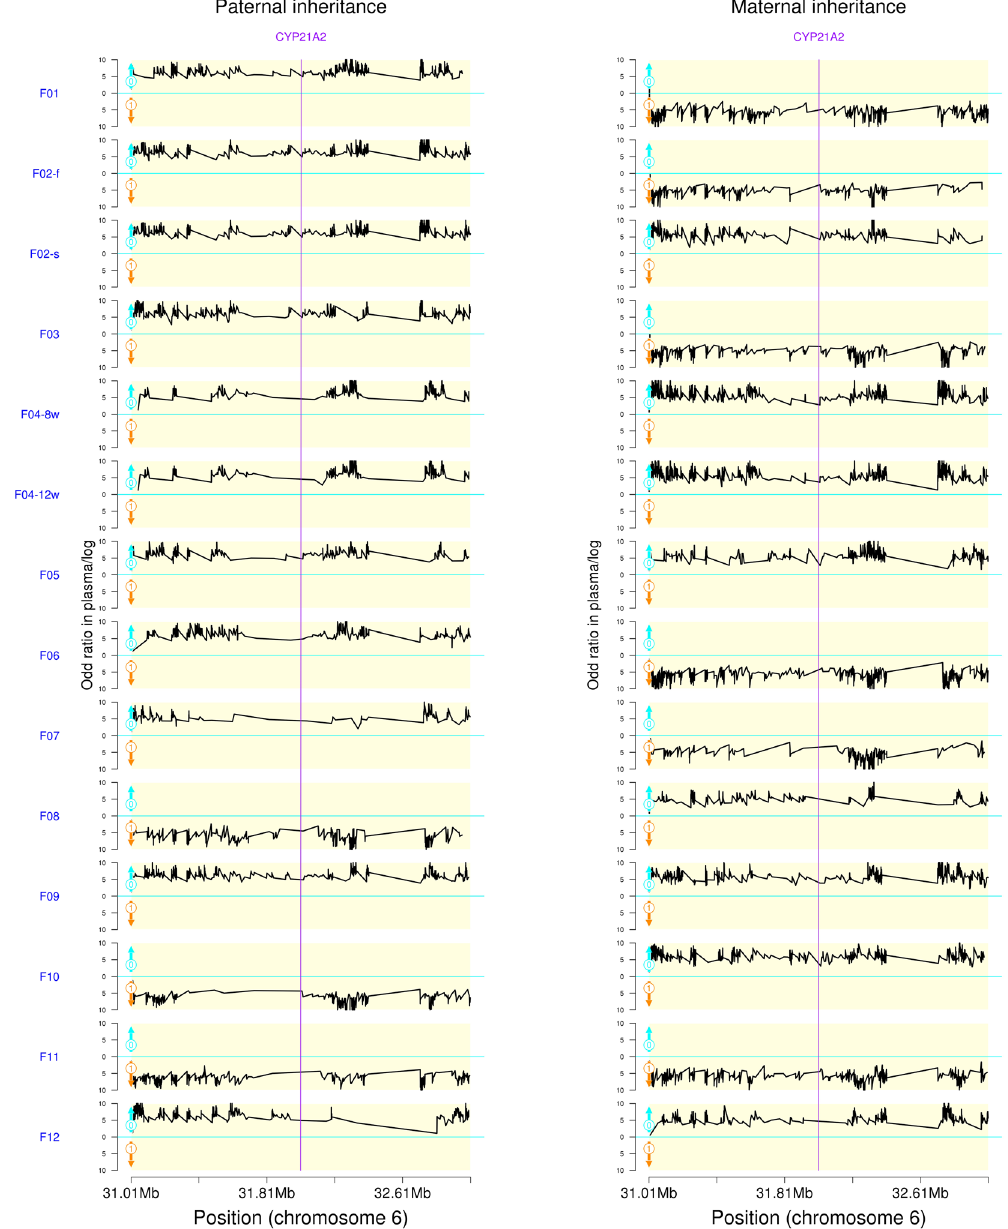
Figure 2. Fetal inheritance of haplotype in families 1 to 12 involving CYP21A2 . Haplotypes are shown within 2 Mbp genomic region flanking the CYP21A2 gene. The inheritance of paternal haplotype is illustrated on the left, and the inheritance of maternal haplotpe is shown on the right. Hap 0 is linked to pathogenic mutations in the CYP21A2 , while Hap 1 is linked to wild-type allele. The black lines indicate haplotype inheritance by the fetus. The logarithmic odds ratio of transmission probability between Hap 0 and Hap 1, and is calculated by P0 * P0re/(P1 * P1re), where P0re is the probability of recombination involving fetal inheritance of Hap 0, and P1re is the probability of recombination involving fetal inheritance of Hap 1. The purple line indicates the region of CYP21A2